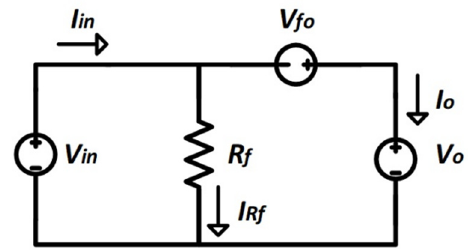
Figure 3. Equivalent circuit in low frequency averaged analysis.